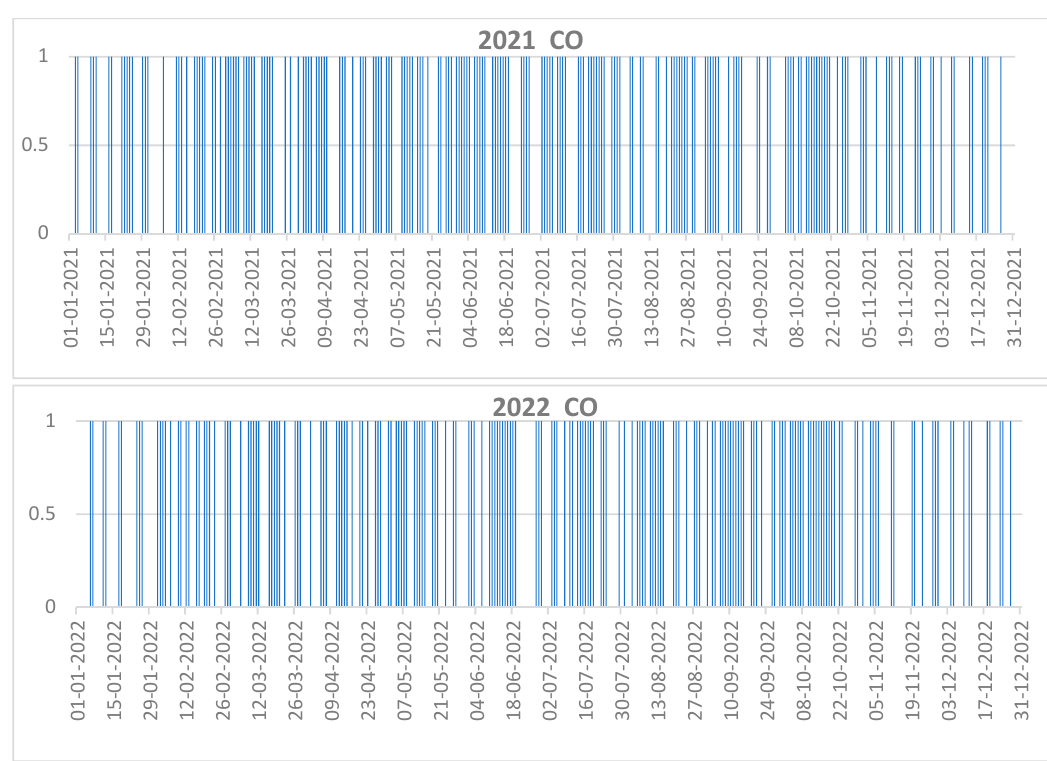
Figure 8. Days with CO emissions of more than 3 σ above the background concentration, Kemerovo region, for each year from 2018 to 2022 separately.